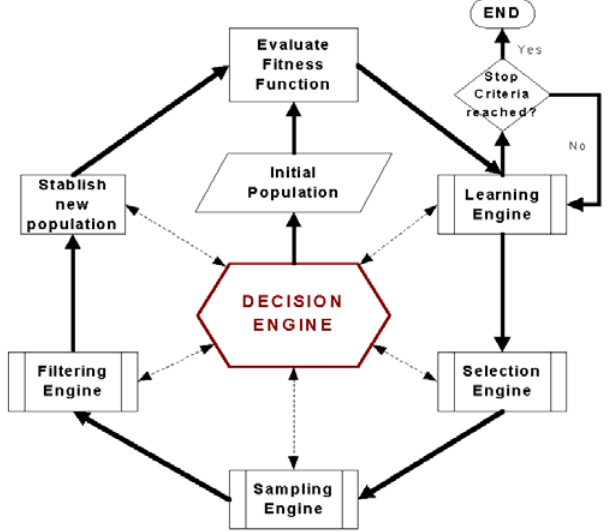
Fig. 1. Scheme of a Flexible Evolution Agent